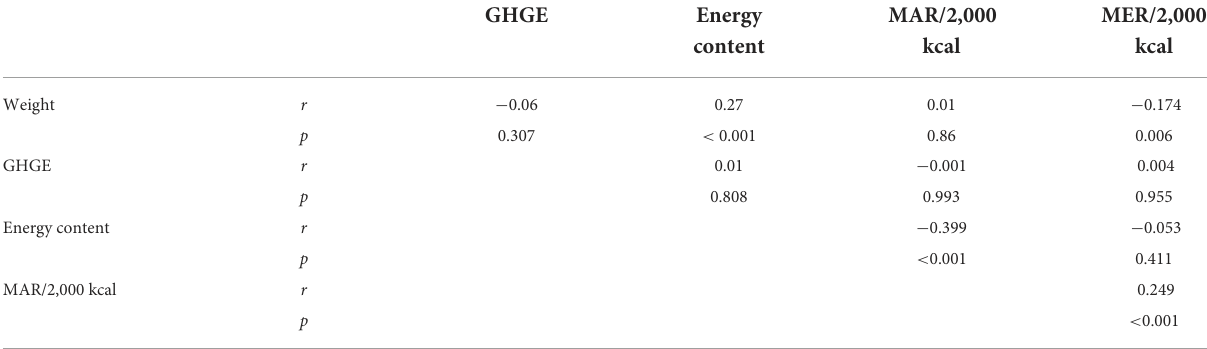
TABLE 1 Pearson’s correlation coefficients between weight, energy content, GHGE, MAR/2,000 kcal and MER/2,000 kcal of the Dijon school meals in 2019 ( n =